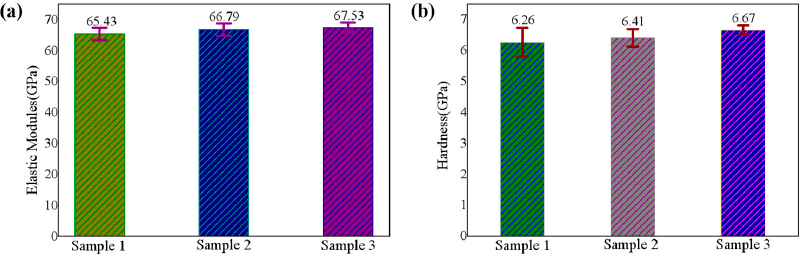
Figure 7. ( a ) Elastic modulus and ( b ) hardness of SiN x films (sample 1 is as-deposited, sample 2 is exposed to the air and sample 3 is placed under 85 °C/85% RH for 18 days).